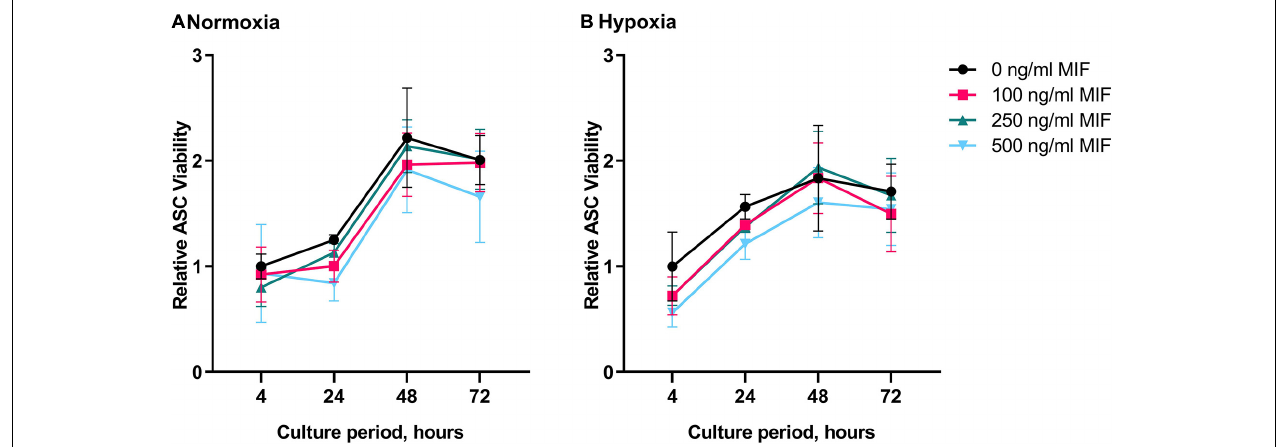
FIGURE 7 | Viability of ASCs under normoxic and hypoxic conditions after MIF stimulation. Cells were stimulated with 100, 250, or 500 ng/ml of recombinant MIF and cultured in growth medium at normoxic oxygen levels of 21% O 2 or hypoxic oxygen levels of < 1% O 2 . Treatment with exogenously added MIF was repeated every 24 h of culture. Viability of ASCs measured by Presto Blue assay was calculated in relation to the baseline value (BL) of the control (0 ng/ml) that did not receive any exogenous MIF at 4 h normoxia, set to one. Analyses were performed on three biological replicates ( n = 3). Results are displayed for ASCs cultured in (A) normoxia and (B) hypoxia. Data are mean values ± SEM (two-way ANOVA, Holm-Šídák’s multiple comparisons test, not